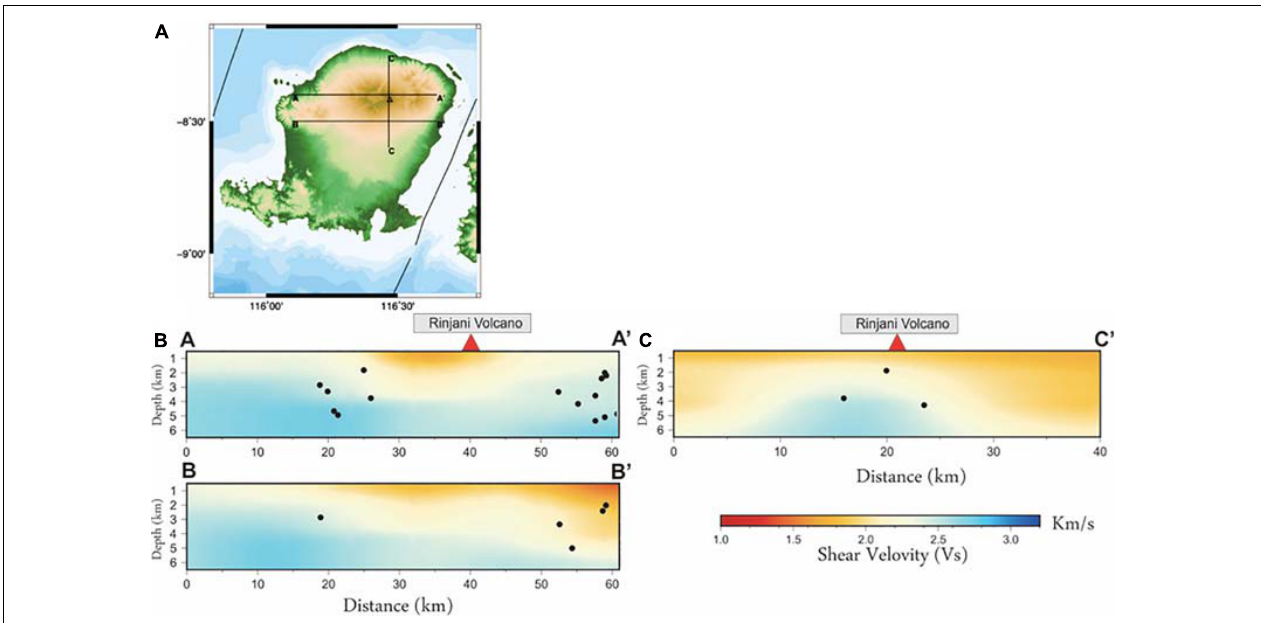
FIGURE 11 | (A) Map of Lombok Island with three back lines show the tracks of the vertical cross-section at line A-A’, B-B’, and C-C’. (B) the vertical cross-section in Lombok Island passing through line A-A’, B-B’, C-C’, where line A-A’ and C-C’ passing through Rinjani Volcano with relocated hypocentres from Sasmi et al. (2020) marked by filled black circles. Blue and red colors indicate high and low shear wave velocity values,